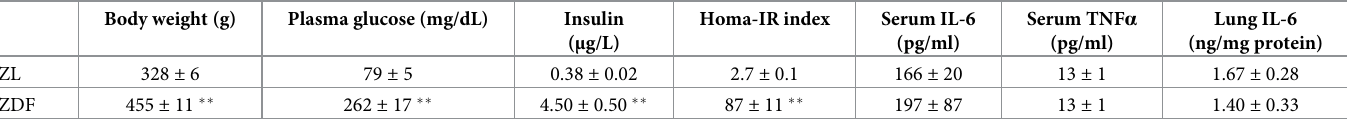
Table 3. Body weight, plasma glucose, insulin, HOMA-IR index and cytokine levels. Body weight (g) Plasma glucose